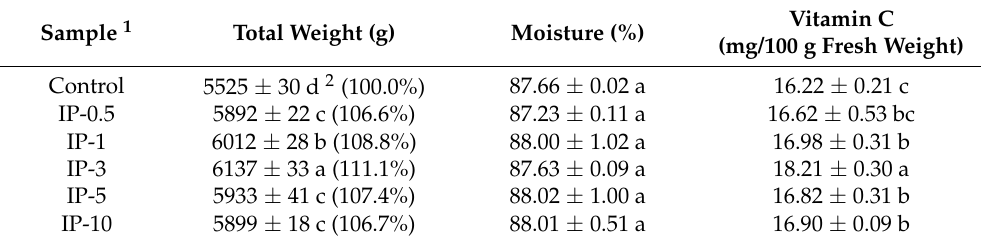
Table 1. Effect of different concentrations of illite treatment on the yield, moisture content, and vitamin C content of soybean sprouts cultivated for 6